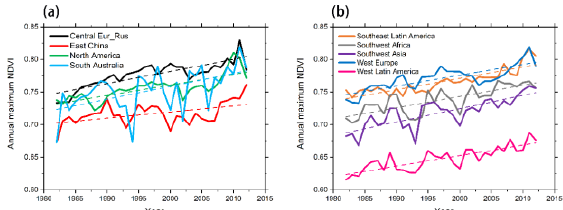
Figure 2. Maximum NDVI trend of nine major crop zones during the entire study period (1982-2012) using GIMMS dataset.